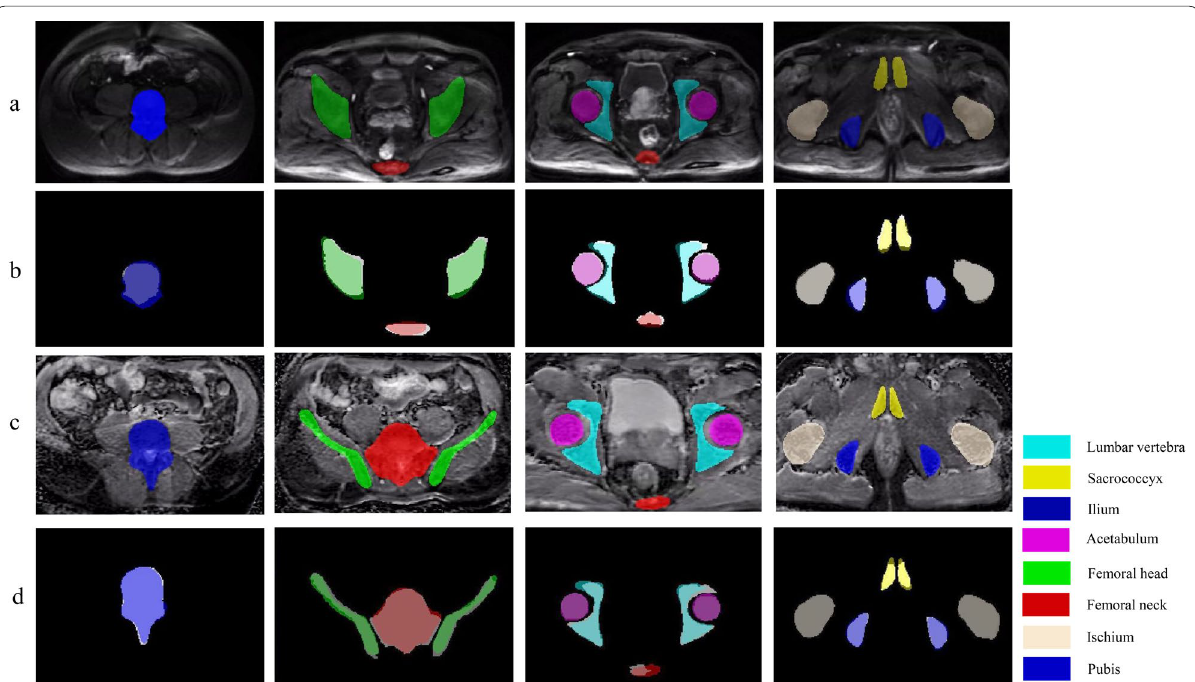
Fig. 5 Examples of the comparison between CNN-predicted and manual segmentations. a Section examples of eight bones on DWI image; b The corresponding overlapping images between manual segmentation (white background) and CNN-predicted segmentation; c Section examples of eight bones on ADC image; d The corresponding overlapping images between manual segmentation (white background) and CNN-predicted